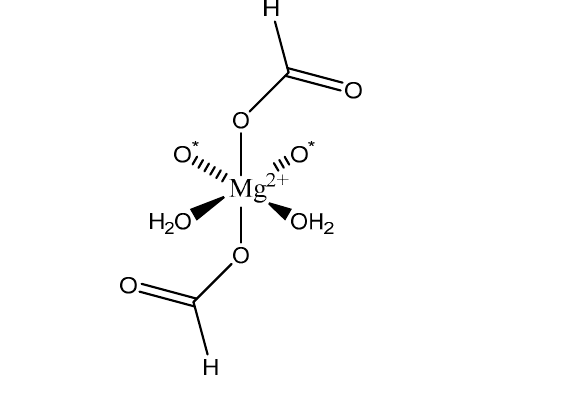
Figure 10. Illustrated structure of the magnesium bis -formate complex reported by Osaki et al.